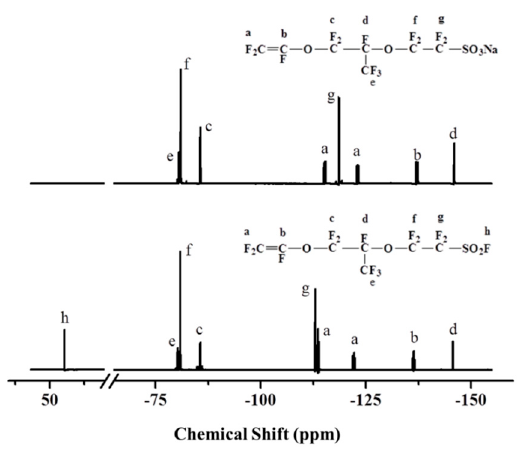
Figure 2. 19 F NMR spectrum of PSVE and PSVNa.